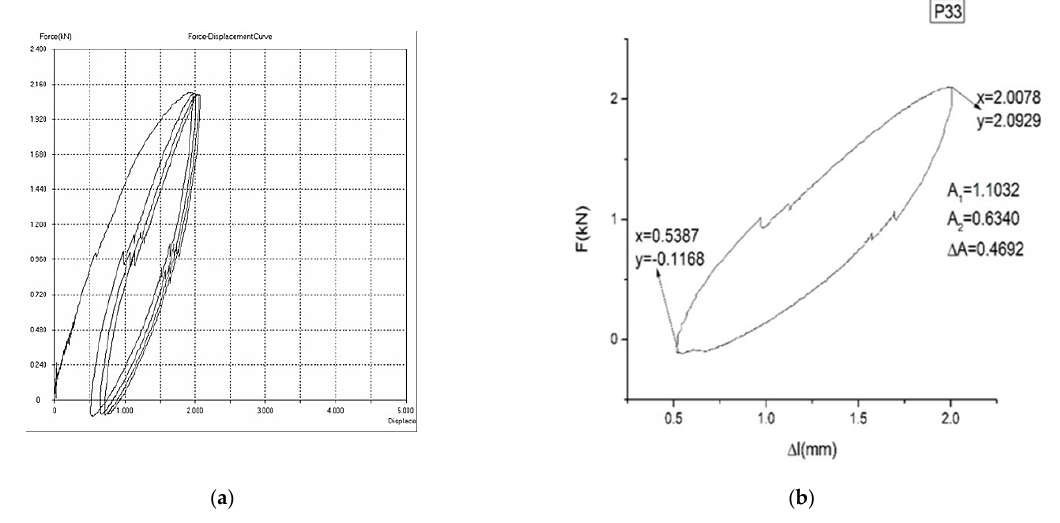
Figure 9. Force–displacement diagram for sample P33: ( a ) F = f( Δ l) for 5 cycles of loading–unloading. ( b ) F = f( Δ l) for the last cycle of loading–unloading. The yield of sample P33 is η = 42.53%. Δ𝐴 is proportional to the dissipated energy in a loading–unloading cycle. A 1 is proportional to the loading energy. A 2 is proportional to the unloading energy. The smaller Δ𝐴 is, the better the yield ( 𝜂 (cid:3404) (cid:4666)(cid:3002) (cid:3117) (cid:2879)(cid:3002) (cid:3118) (cid:4667) ) of the material transformation is (and, therefore, a